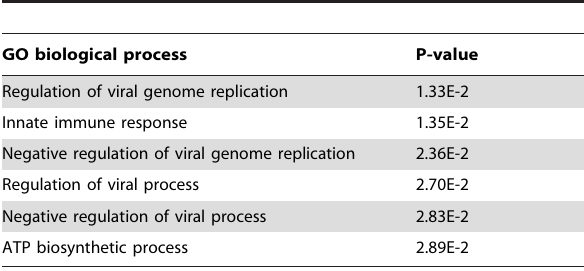
Table 3. List of the GO biological processes enriched for the proteins present in the STRING protein network.